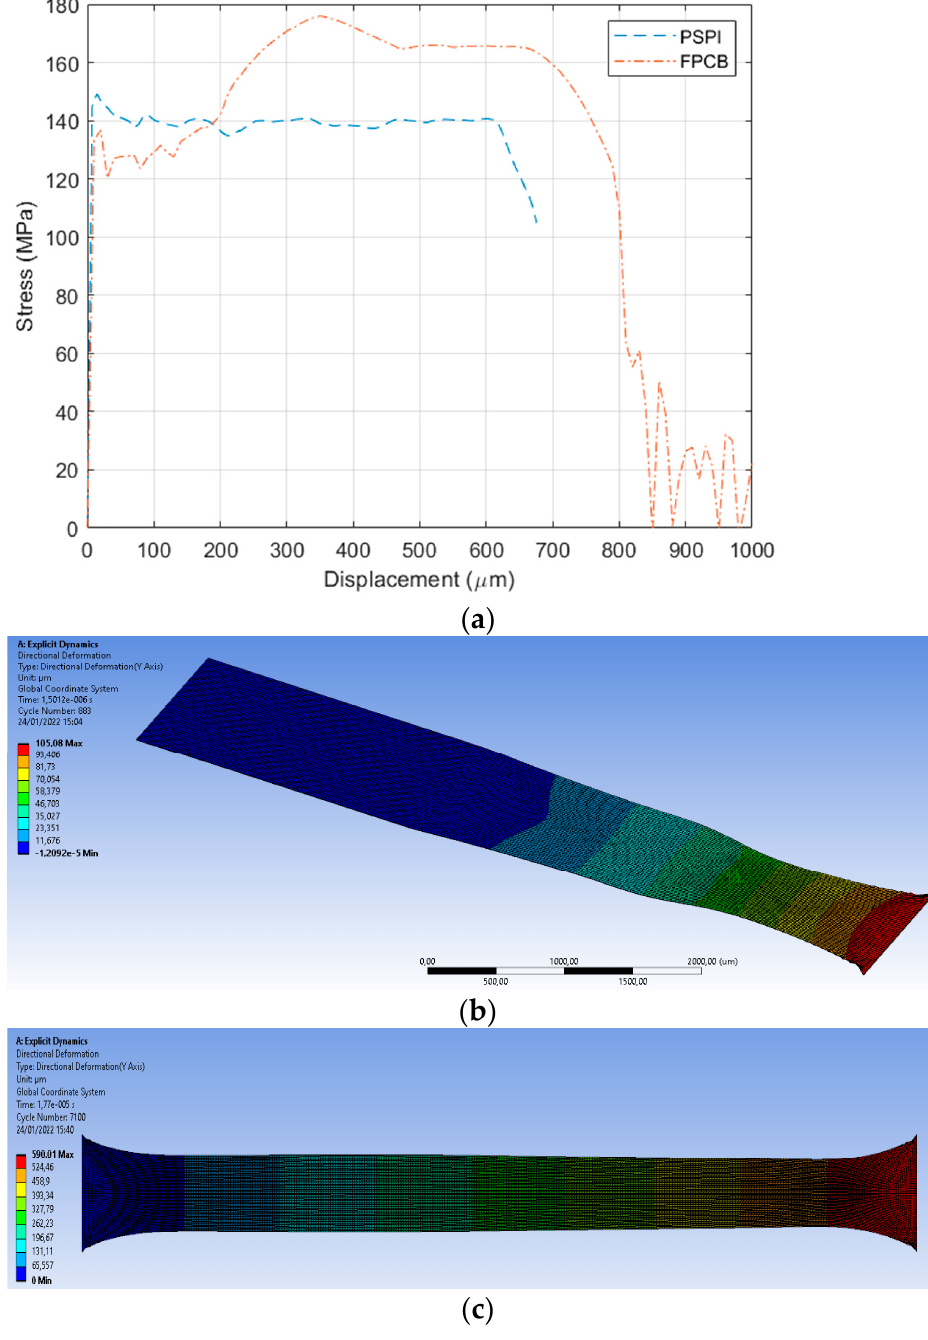
Figure 11. Explicit Dynamics simulation results. ( a ) Stress and displacement curves. ( b ) Necking of PSPI (magnified by 12). ( c ) Necking of FPCB.